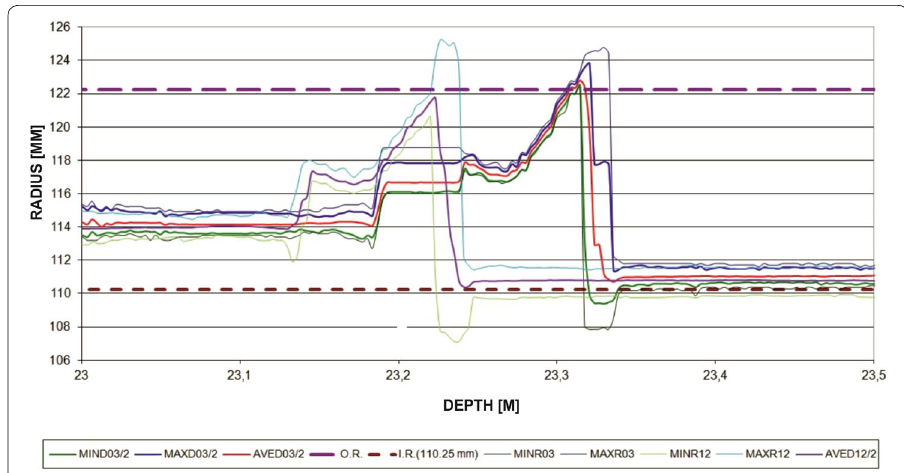
Fig. 7 Comparative graph of pipe radius and pipe diameter testing using the MIT60 probe at a depth of approximately 23 m, 2003 and 2012 (Bujakowski et al. 2013a)